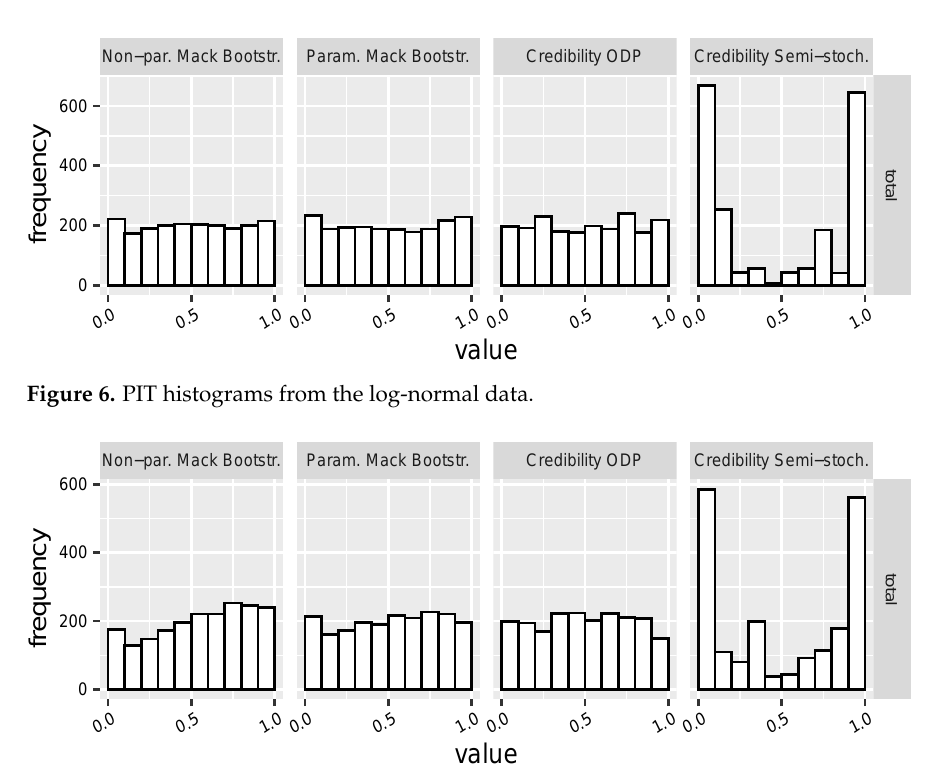
Figure 7. Histograms of PIT values from the gamma